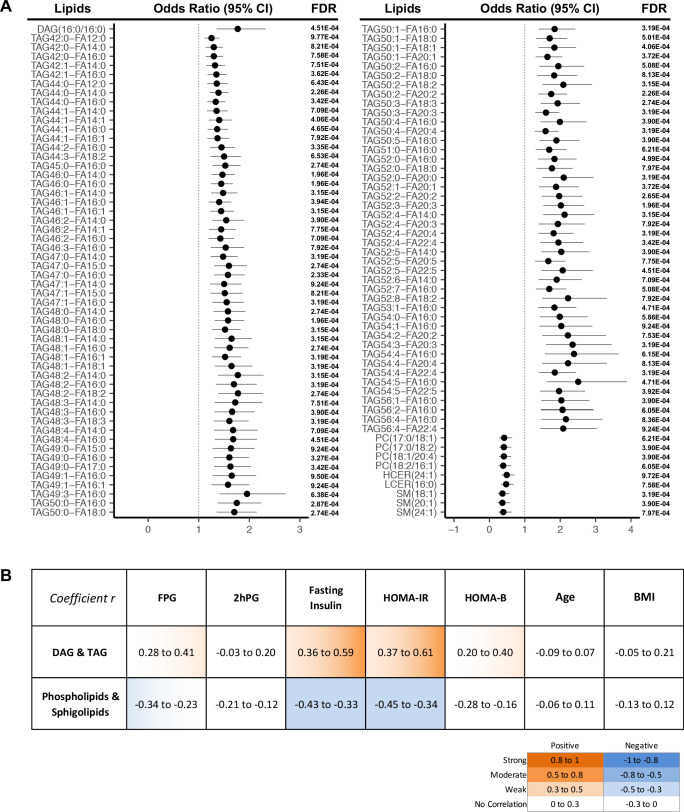
Lipids strongly associated with risk of incident T2D.(A) Odds ratio and 95% CI of 107 lipids strongly associated with T2D risk (FDR < 0.001) were indicated. The multivariate logistic regression model was adjusted for race, age and BMI. (B) Correlation between 107 T2D-risk associated lipids and conventional clinical parameters was indicated by correlation coefficient (r). Orange color indicates positive correlation while blue denotes negative correlation.Figure 3—source data 1.Odds ratio, 95% CI and FDR values of all lipids. Lipids with FDR < 0.001 were highlighted.Figure 3—source data 2.Correlation r values of T2D risk associated lipids with clinical parameters.